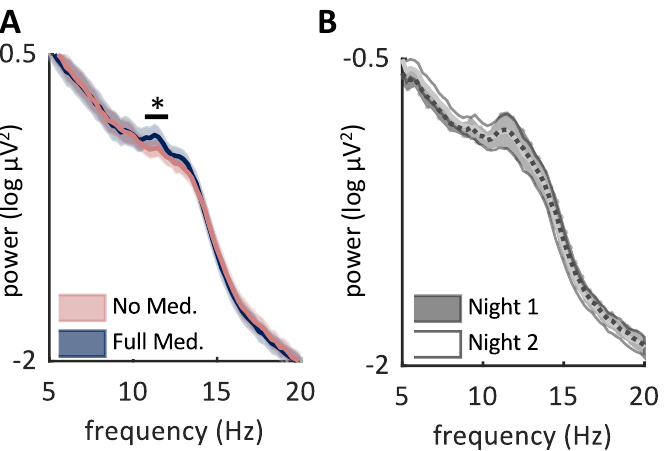
Figure 2. Spindle power is enhanced with anti-seizure medication. ( A ) EEG power in the 5–20 Hz frequency band for stage N2 and N3 sleep in the Epilepsy group (left) and Control group (right). Cluster based permutation test across frontal and central electrodes revealed a significant difference between the night where ASM were given (blue) compared to no medication (pink) in patients with epilepsy ( p = 0.030, black band shows the significant range from 10.77 to 12.00 Hz). Graph shows mean± SEM. ( B ) No difference was found between two sequential nights of sleep in the Control group (10,000 iterations p < 0.05). Graph shows mean± SEM. * p < 0.05.